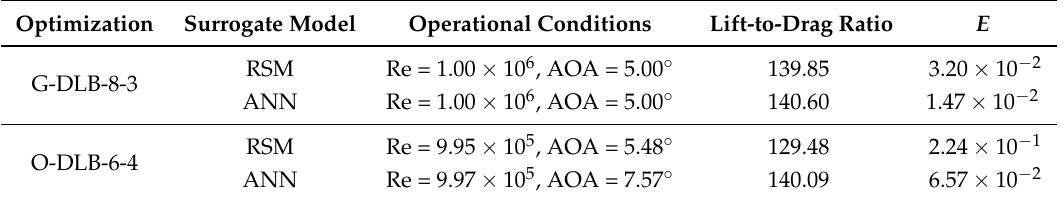
Figure 7. The optimal designs of the wind turbine airfoils plotted with the baseline airfoil. The optimal designs in ( a , b ) are obtained using the surrogate models created with G-DLB-8-3 and O-DLB-6-4, respectively. Table 5. The values of the lift-to-drag ratios of the optimal designs. Note that the lift-to-drag ratio of the baseline design at Re = 10 6 , AOA = 5 ◦ is